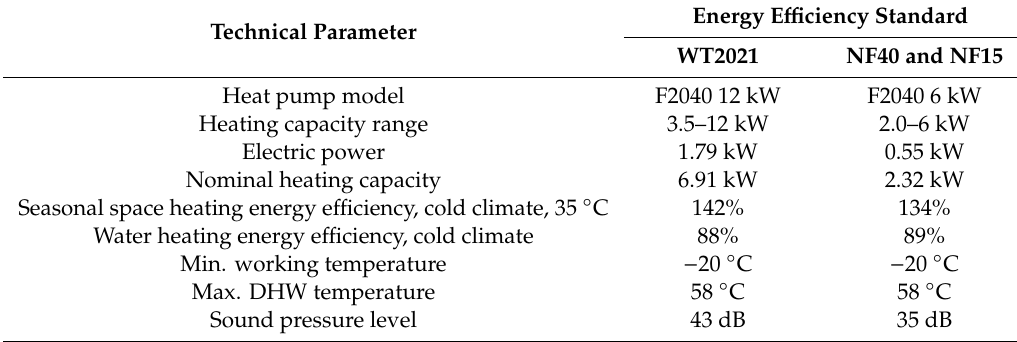
Table 7. Basic technical parameters of the air source heat pump (ASHP) selected for the WT2021, NF40 and NF15 standards [29].